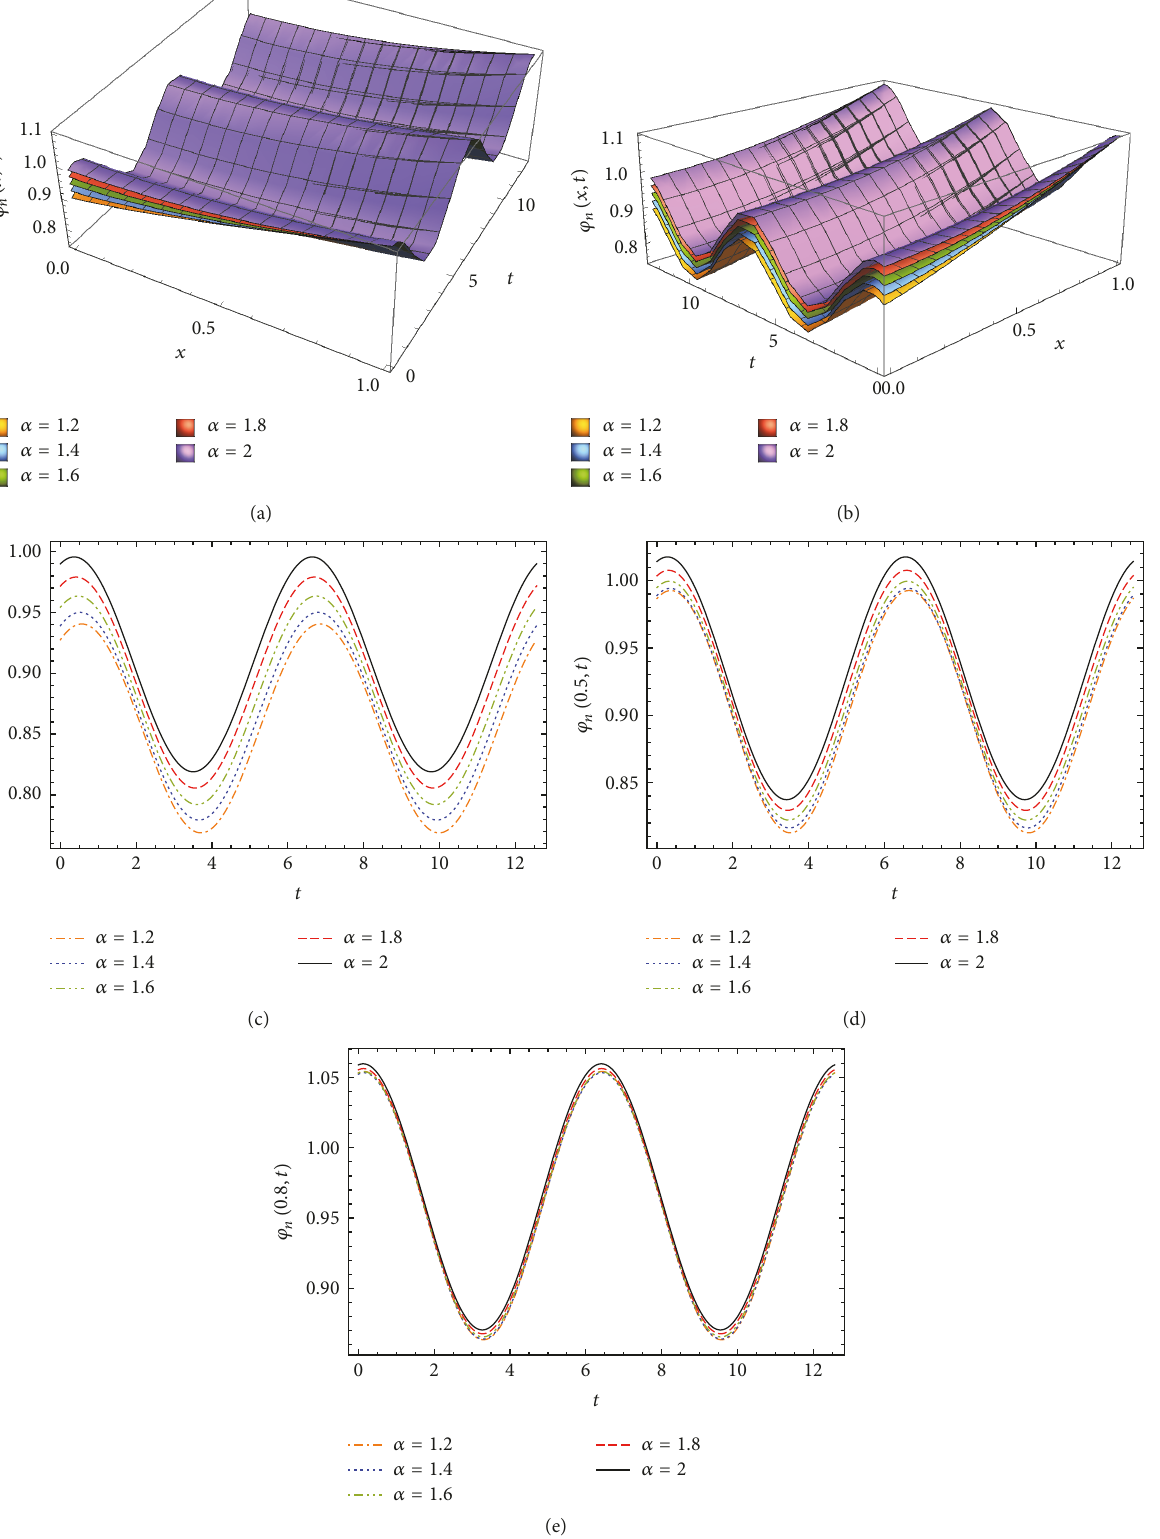
Figure 4: ((a)-(b)) Surfaces of approximate solutions 𝜑 5 (𝑥,𝑡) for the values of 𝛼 = 1.2, 1.4, 1.6, 1.8, 2 with different angles of view. ((c)–(e)) Cross sections of the surfaces of 𝜑 5 (𝑥,𝑡) at 𝑥 = 0.2 , 𝑥 = 0.5 , and 𝑥 = 0.8 , respectively, for 𝛼 = 1.2 (dot-dash), 𝛼 = 1.4 (dot line), 𝛼 = 1.6 (dot-dot-dash), 𝛼 = 1.8 (dash line), and 𝛼 = 2 (solid